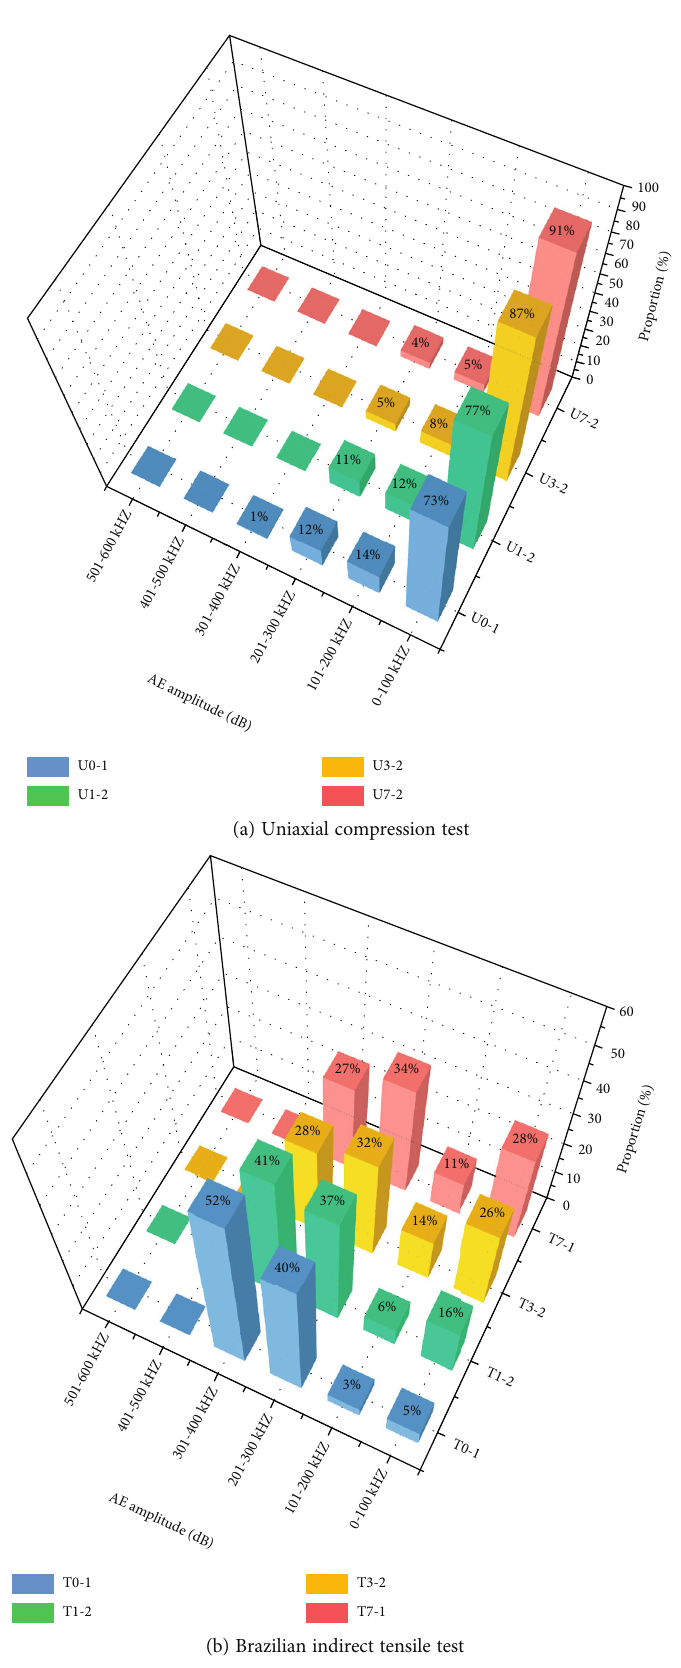
Figure 5: Comparisons of AE peak frequency distributions. (a) Uniaxial compression test. (b) Brazilian indirect tensile